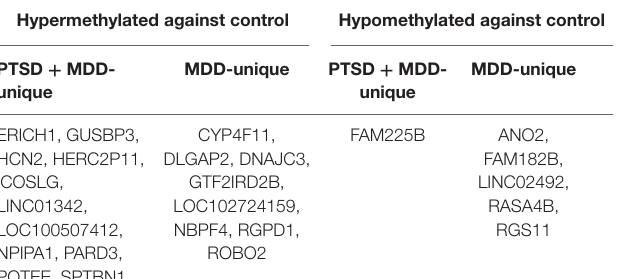
TABLE 4 | PTSD + MDD-unique and MDD-unique genes with de-methylated cytosines. Hypermethylated against